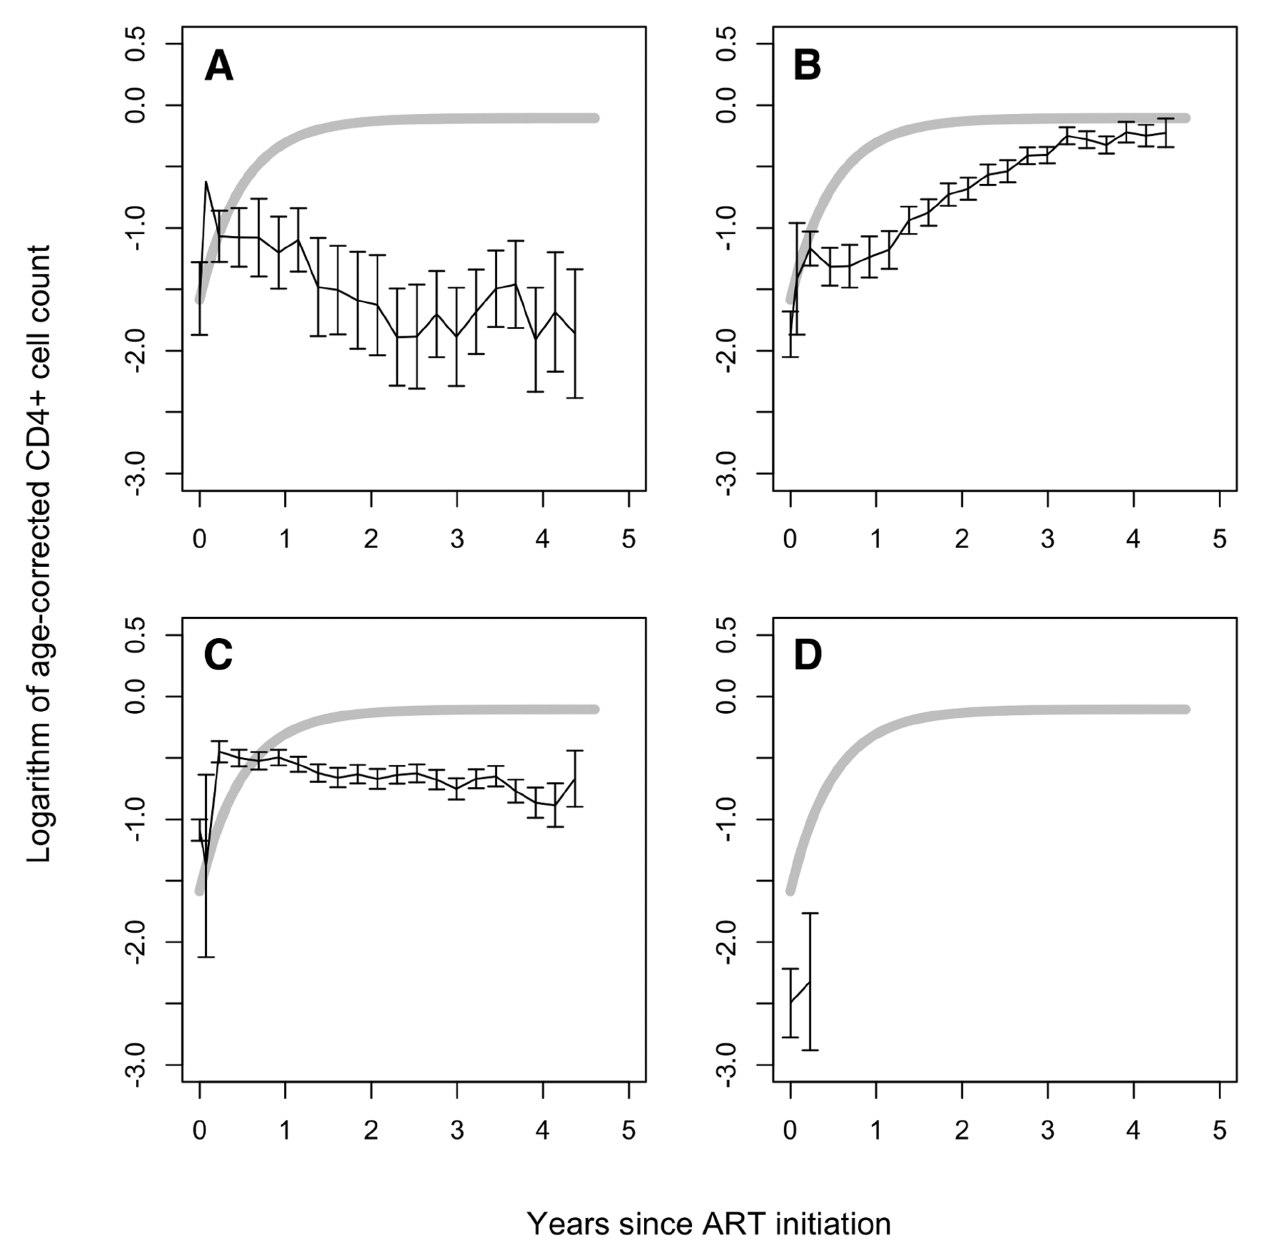
Figure 4. CD4-for-age in children not showing asymptotic reconstitution. Mean CD4 cell count for age with time since ART initiation (error bars: standard error of the mean) for: (A) 23 children with significant ( p , 0.05) decreasing CD4-for-age with time; (B) 79 children with significant ( p , 0.05) increasing CD4-for-age with time but not fitting the asymptotic model; (C) 153 children with no significant change ( p . 0.05) in CD4-for-age with time; and (D) 37 children with only baseline CD4 count available. For comparison to the asymptotic group, grey lines indicate average (fixed- effects, for a 6-y-old girl with weight-for-age z -score 2 2.2) CD4-for-age in the 914 children with asymptotic CD4 reconstitution. In (A–C), data points are shown where . 20% of children in each group remained in the trial.